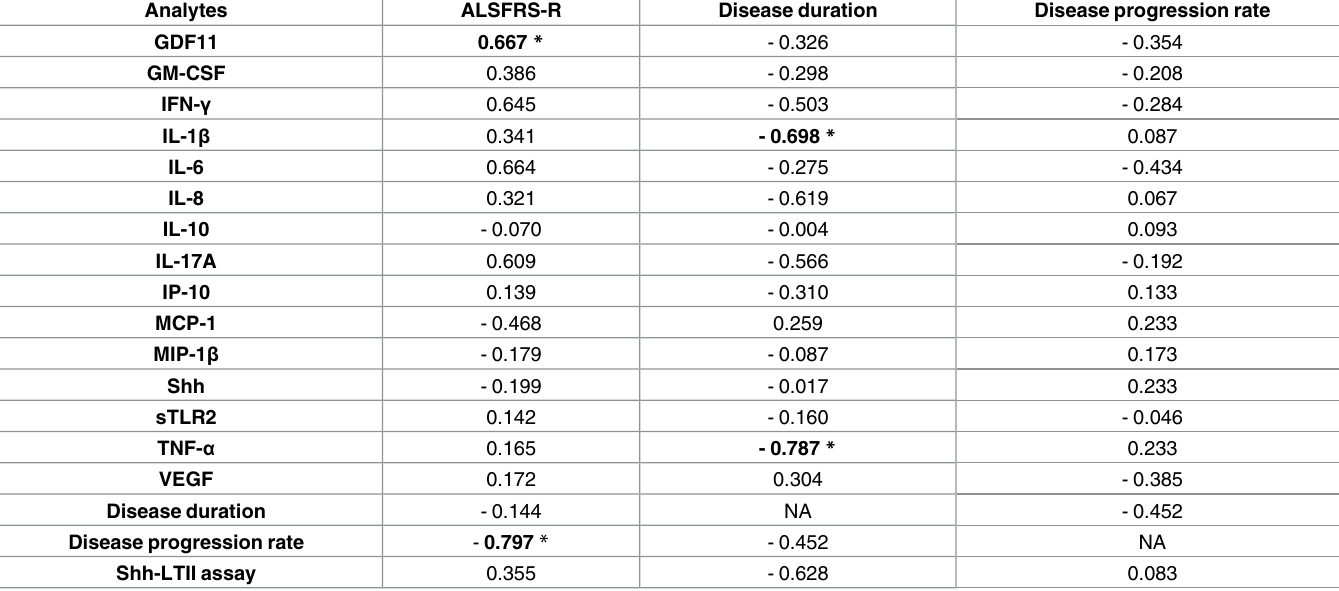
Table 4. Correlations (Spearman r ) between levels of individual analytes in CSF of ALS group, luminescence measuredin arbitraryunits in Shh- LTII assay and ALSFRS-R, disease duration, and disease progression